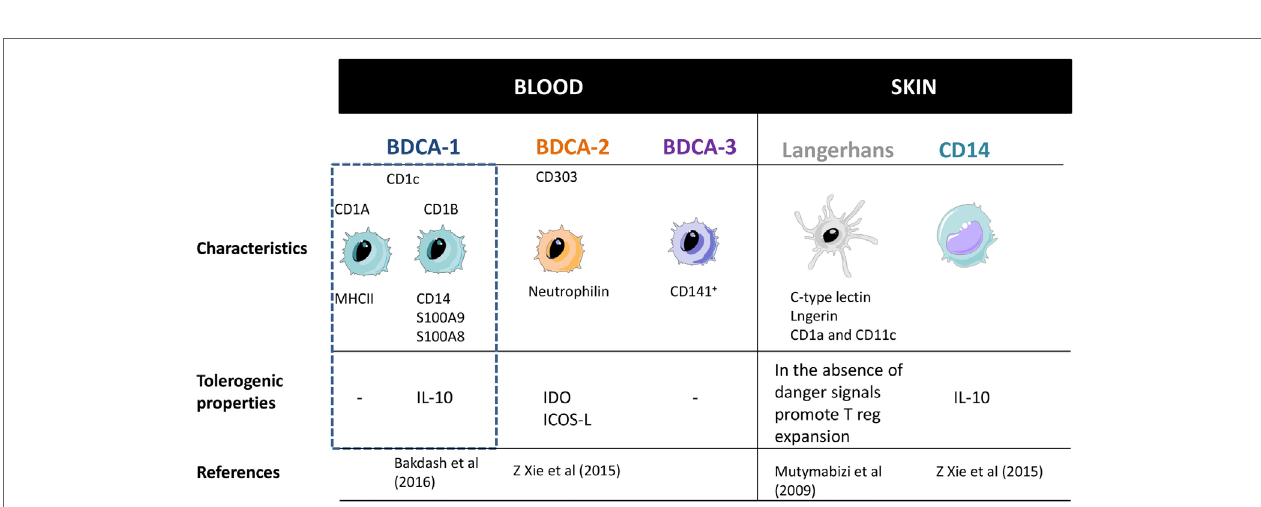
FigURe 2 | Maturation process of dendritic cells (DCs). Adapted from: Steinman et al. (29). LN, lymph